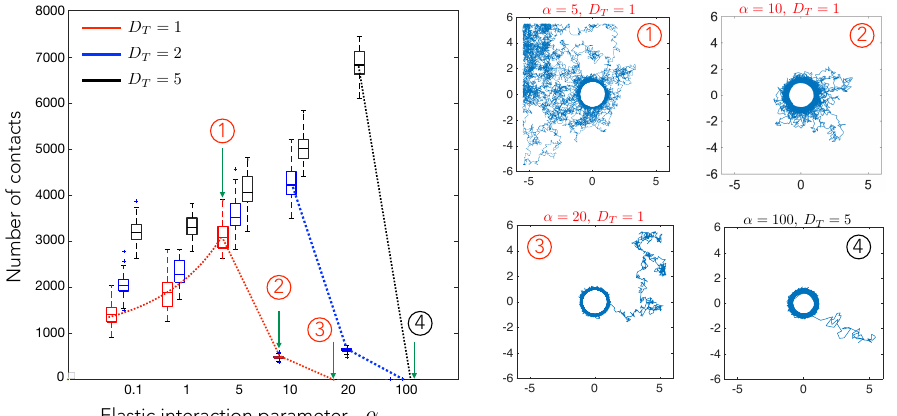
Elastic interaction parameter, <latexit sha1_base64="W4NsZ3UdMd3JSqHJ0nbSZyXsADw=">AAAB7XicbVDLSgNBEOz1GeMr6tHLYBA8hV0R9Rj04jGCeUCyhN7JbDJmdmaZmRVCyD948aCIV//Hm3/jJNmDJhY0FFXddHdFqeDG+v63t7K6tr6xWdgqbu/s7u2XDg4bRmWasjpVQulWhIYJLlndcitYK9UMk0iwZjS8nfrNJ6YNV/LBjlIWJtiXPOYUrZMaHRTpALulsl/xZyDLJMhJGXLUuqWvTk/RLGHSUoHGtAM/teEYteVUsEmxkxmWIh1in7UdlZgwE45n107IqVN6JFbalbRkpv6eGGNizCiJXGeCdmAWvan4n9fObHwdjrlMM8sknS+KM0GsItPXSY9rRq0YOYJUc3croQPUSK0LqOhCCBZfXiaN80pwWfHvL8rVmzyOAhzDCZxBAFdQhTuoQR0oPMIzvMKbp7wX7937mLeuePnMEfyB9/kDjSePHQ==</latexit> ↵ Figure 3. The number of cell–cell contact events measured in a fixed interval of time depends strongly on the elastic interaction parameter. A contact event is identified as cell A coming within a prescribed contact radius of cell B with cell A initialized randomly in a certain area around cell B. Thus the number of contact is be interpreted as the average number of contacts of the two cells. The number of simulation runs conducted were 50 for each combination of D T and α . The dashed curves are guides to the eye illustrating the trends seen with increasing values of α . Diffusion is the major factor in governing the number of contacts for low values of α . For higher α , the attractive potential increases the probability of the cell to stay near the contact radius and controls the number of contacts. The trajectories for highlighted data points (1)–(4) are shown on the right. The box plots show the distribution of contact numbers. The lower and upper bounds of the box are the first and the third quartiles respectively, while the line in middle is the median. The lower and upper limits of the dashed lines are the minimum and maximum number of contacts observed for cells for each combination of α and D T . The simulation was run for a total time of T = 1000 and updates in the cell position were made every δ t =